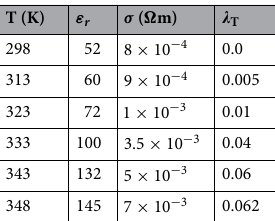
Table 3. The parameters used to simulate the I – V curves in Fig.